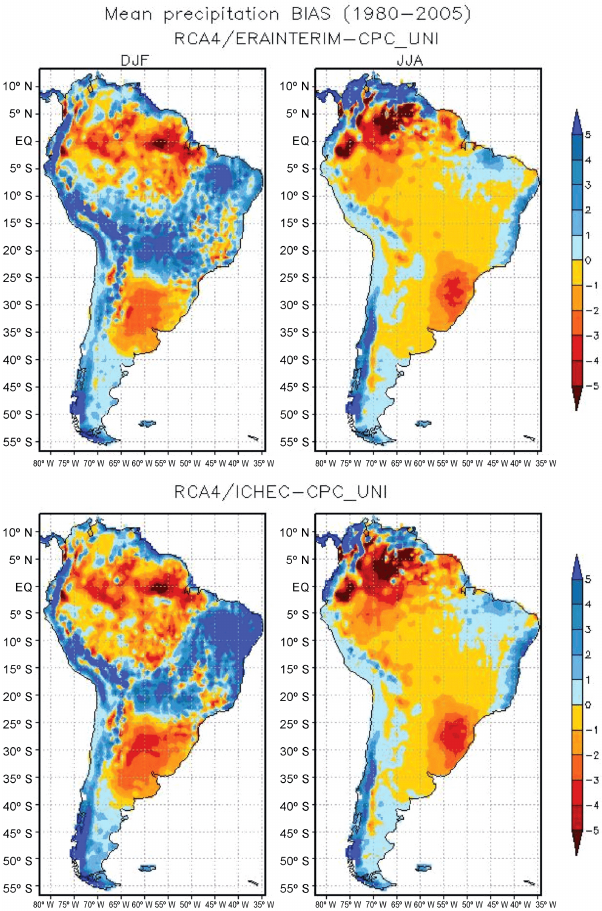
Figure 2. Change in average precipitation for 2017–2100 minus 1980–2005 projected by regional model RCA4 for South Amer- ica when using the RCP4.5 scenario and two different sources of boundary conditions: the EC-Earth GCM run by the ICHEC (top row) or the low-resolution version of the Max Planck Institute (MPI) earth system model (bottom row). Changes are for the sea- sons December–January–February (DJF; left side) and June–July– August (JJA; right side). Units are mmd − 1